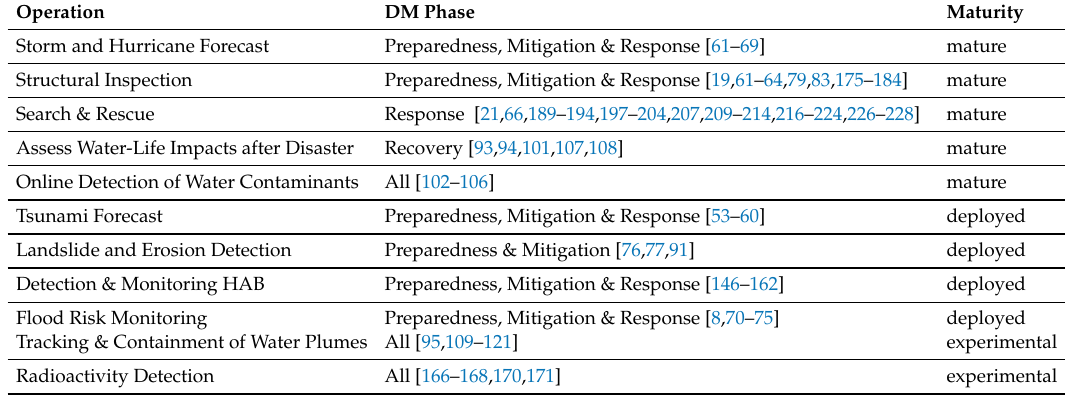
Table 5. USVs Capabilities for Disaster Robotics.